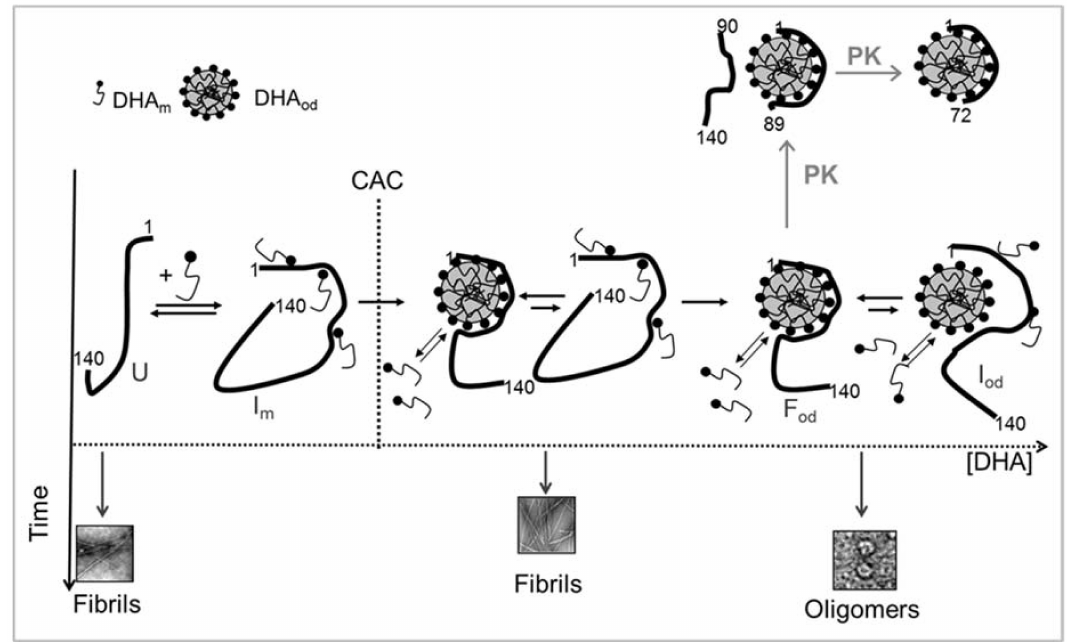
Figure 4. Conformational transition and aggregation of α -syn in the presence of DHA. The DHA self-assembly process as a function of the critical aggregative concentration (CAC) in the presence of the protein is shown. DHA m and DHA od represent the fatty acid monomer and the oil droplet containing DHA, respectively; U, the unfolded free protein; I m , the protein in the presence of non-saturating concentration of DHA; F od , the protein in the presence of oil droplets; I od , the species in equilibrium with the lipid-bound protein. The early and subsequent proteolytic events by proteinase K (PK) are shown. In the absence of DHA, α -syn, unfolded in solution (U), undergoes structural transition and forms amyloid-like fibrils. In the presence of DHA (P/DHA ≥ 10), free α -syn molecules are in equilibrium with the bound ones. Under this condition, transient intermediates form (I m ), and these species evolve in amyloid-like fibrils, as free α -syn molecules are available. The aggregation occurs in a shorter time than in the absence of the fatty acid. In the presence of DHA (P/DHA ≥ 50), all α -syn molecules are bound to the fatty acid (F od ), acquiring an α -helical conformation, and the formation of stable oligomers